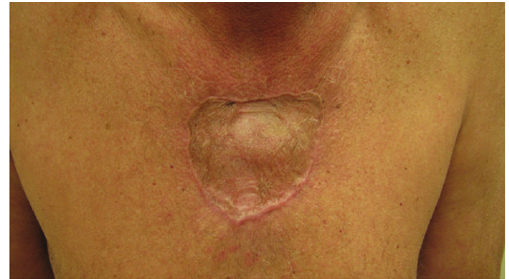
Figure 5: Partial-thickness skin graft after complete